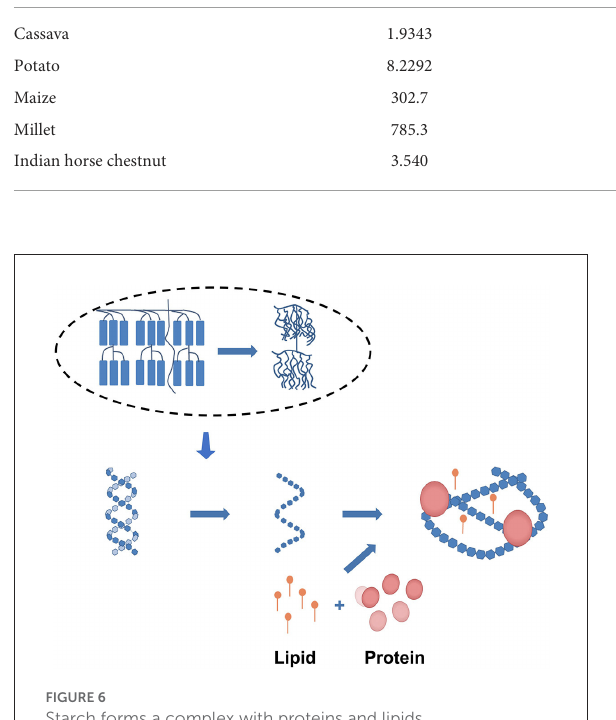
known as starch gelatinization. Gelatinization is defined as the breakdown of hydrogen bonds, the loss of association, and the separation of the double helix when water is introduced into starch grains. The starch molecules are then distributed in water, resulting in a hydrophilic colloid